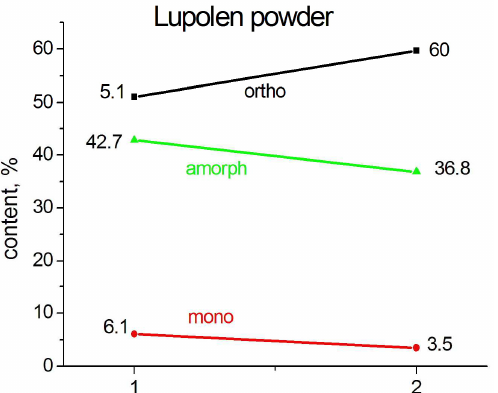
Figure 11. Phase composition of Lupolen film compressed at P = 1 GPa (1) after its heating to 370 K and fast cooling to room temperature (2).